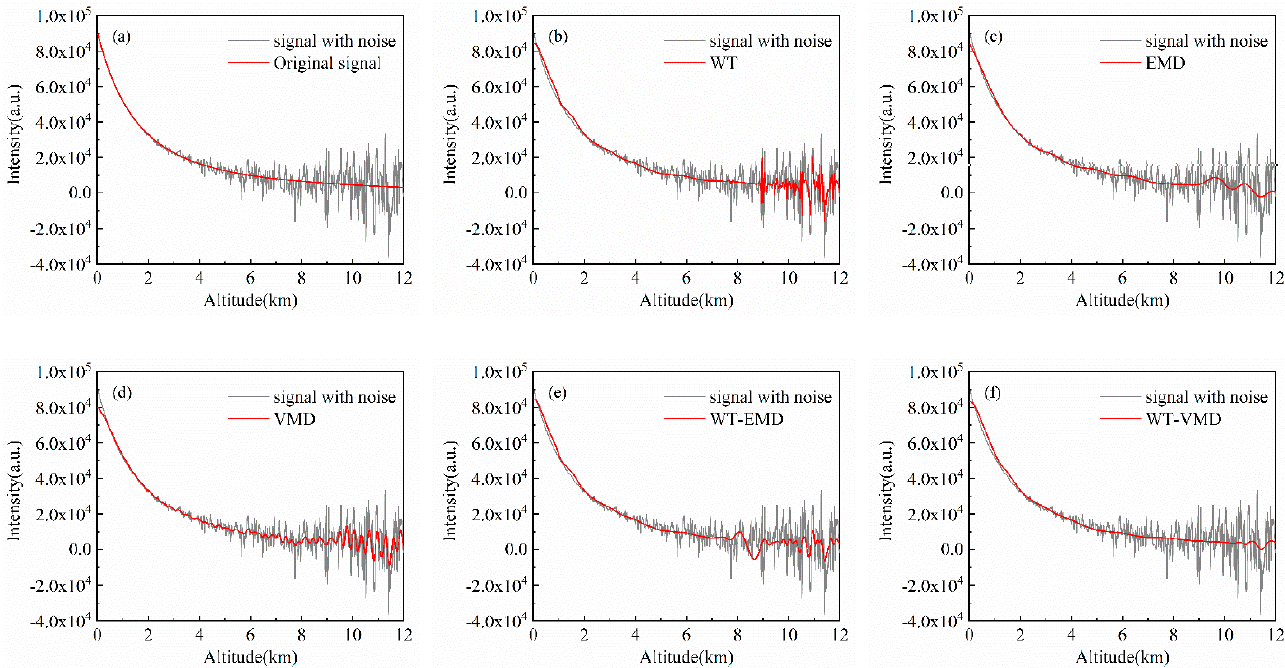
Figure 2. Experimental results of denoising of 50-pulse cumulative simulation signals (no pollution):